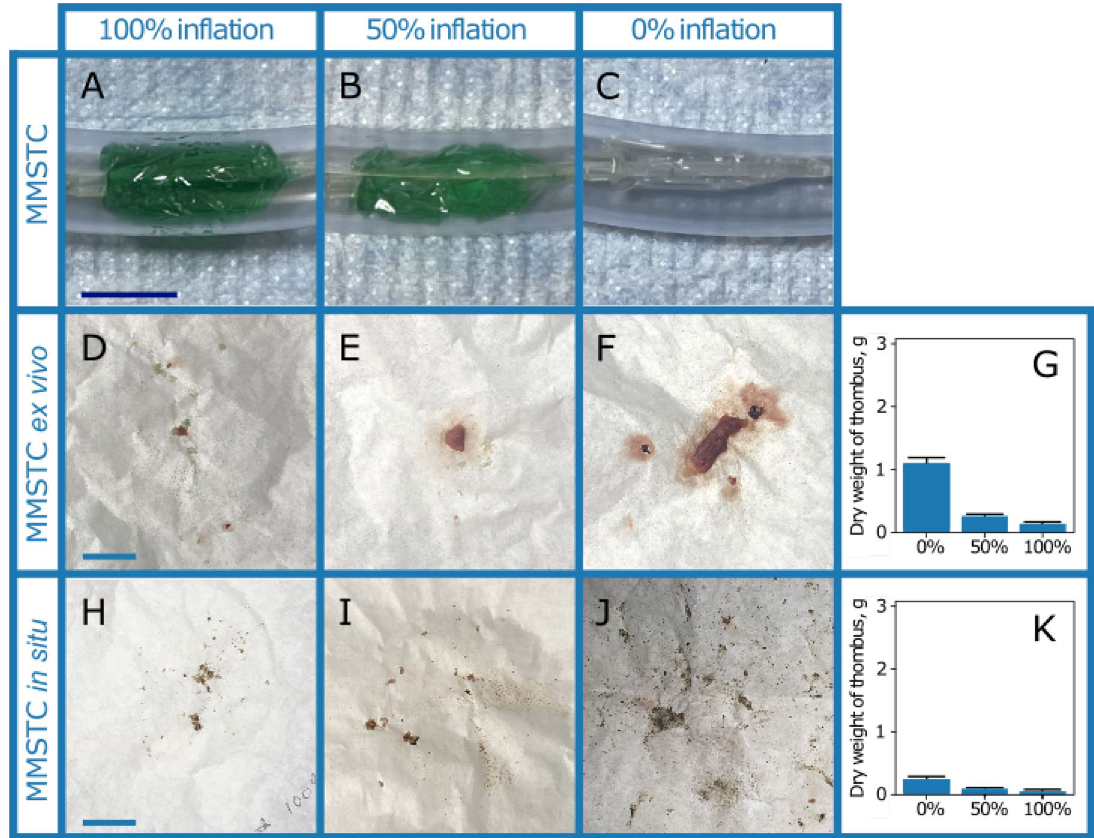
Figure 6. ( A – C ) Multi-modal sequestering thrombectomy catheter (MMSTC) with sequestering distal embolic balloon inflated at 0%, 50%, and 100% in ex vivo testing apparatus. ( D – F ) Representative distal emboli collected on filter paper in the laboratory flow system with MMSTC balloons inflated at 0%, 50%, and 100%. ( G ) The balloons caused a significant reduction in distal embolization. ( H – J ) Representative distal emboli collected on filter paper in the laboratory flow system with MMSTC balloons inflated at 0%, 50%, and 100%, in a bovine vena cava segment. ( K ) The balloons again caused a significant reduction in distal embolization.All scale bars: 2